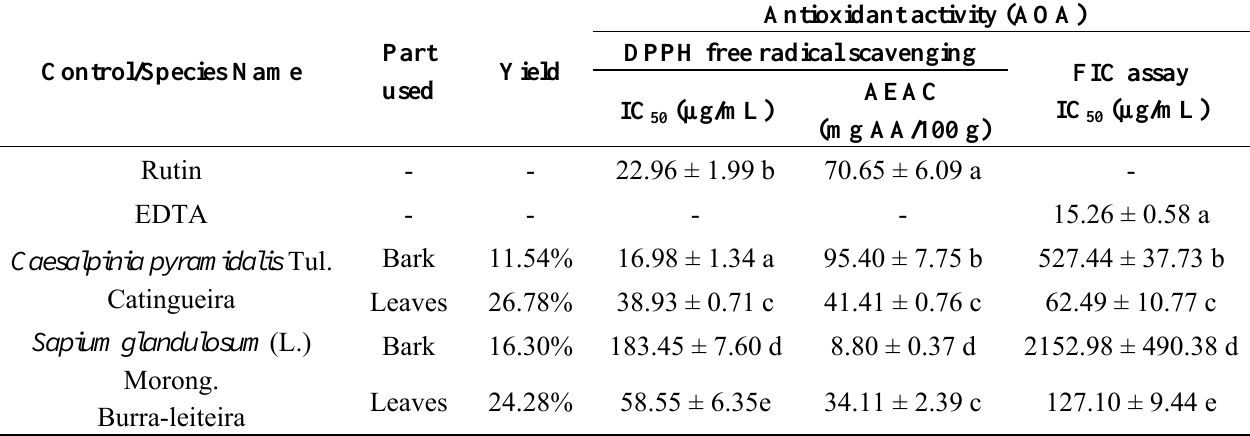
Table 2. Radical scavenging activity (DPPH assay), ascorbic acid equivalent antioxidant capacity (AEAC) and chelating activity (FIC assay) of the bark and leaves of C. pyramidalis Tul. and S. glandulosum (L.) Morong.